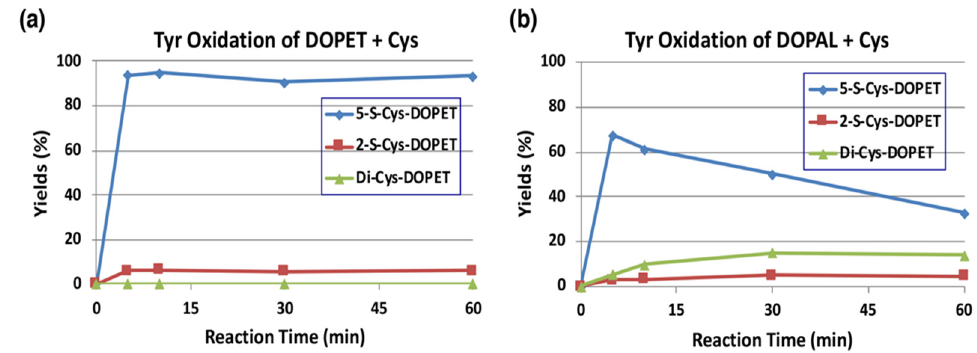
Figure 5. Time course of HPLC following of the tyrosinase-catalyzed oxidation of DOPET or DOPAL (100 µ M) in the presence of Cys (200 µ M) at pH 7.4 and 37 ◦ C. ( a ) DOPET. ( b ) DOPAL. Reaction was stopped by the addition of NaBH 4 followed by 0.8 M HClO 4 . Data were obtained from averages of two independent experiments ( a , b ).